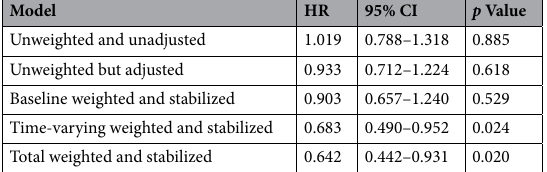
Table 2. Estimated effect of HAART on TB incidence among 800 HIV-infected children initiating HAART, southwest Ethiopia, 2010–2014.